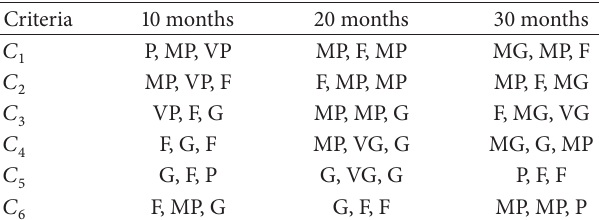
Table 4: Experts data